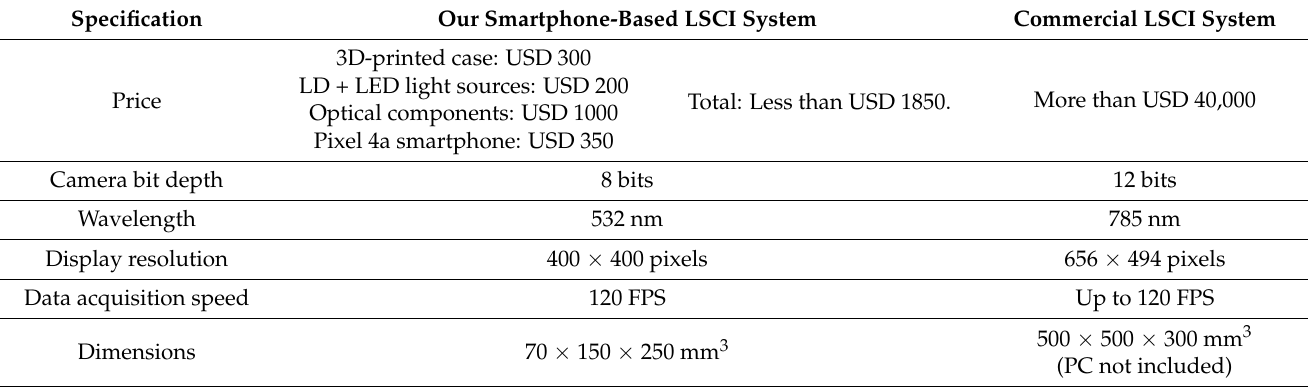
Table 1. Specification comparison of the prototype smartphone-based LSCI endoscope device and a representative commercial LSCI system